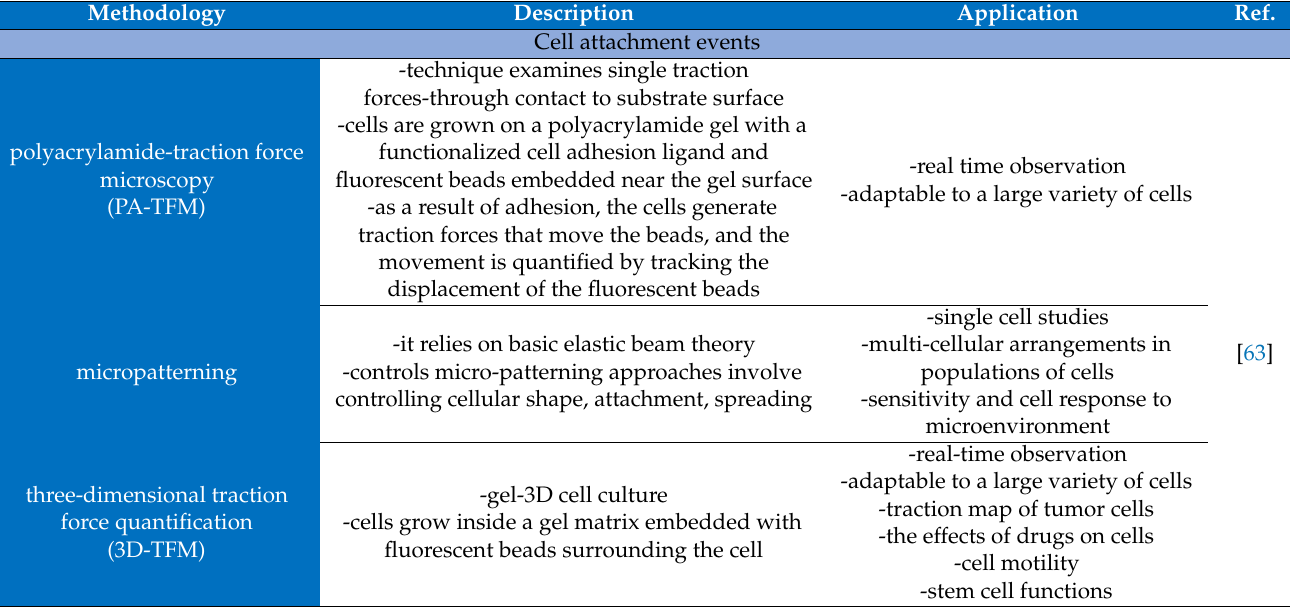
Table 2. Description of the methodology for studying attachment or detachment events during adhesion.